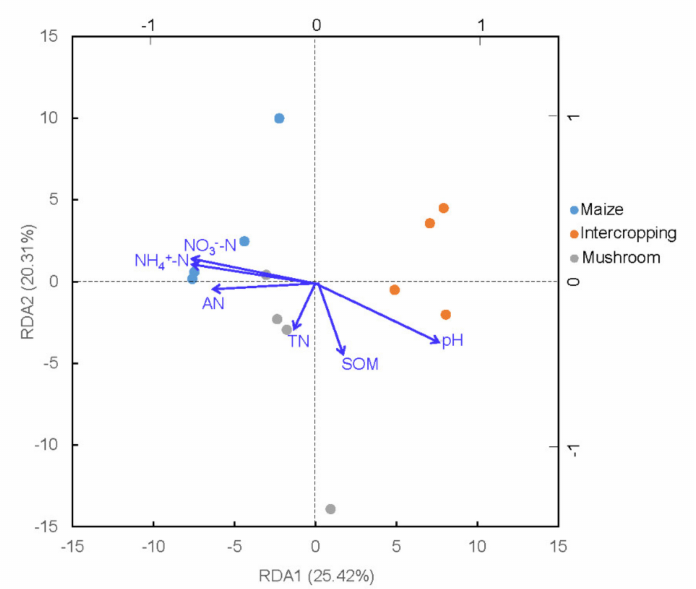
Figure 6. Redundancy analysis (RDA) of soil bacterial community structure and soil properties under maize monoculture, mushroom monoculture and intercropping. Soil factors indicated in blue text include pH, contents of organic matter (SOM), total nitrogen (TN), available nitrogen (AN), nitrate nitrogen (NO 3 − -N) and ammonium nitrogen (NH 4 + -N). The circles are the RDA scores of the samples and the arrows are the scores of the soil variables by RDA. The number of replicates per treatment is 4 ( n =